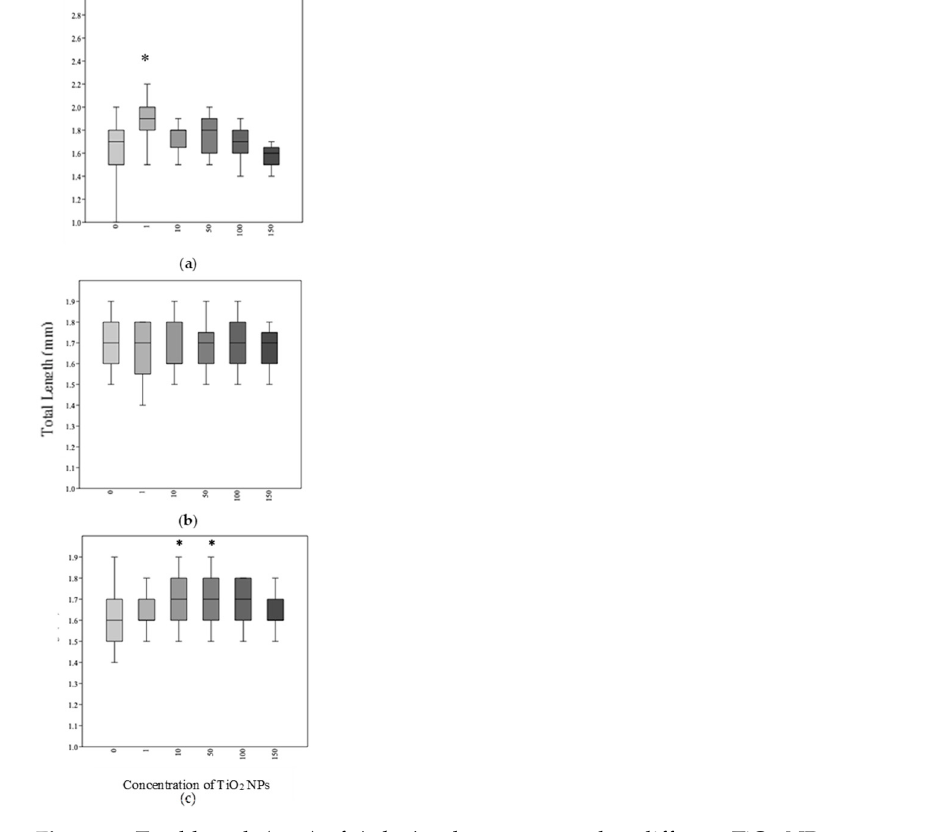
Figure 6. Total length (mm) of A. lanipes larvae exposed to different TiO 2 NPs concentrations for ( a ) 24 h (* p < 0.01), ( b ) 48 h (* p < 0.01), and ( c ) 72 h. (* p < 0.05).